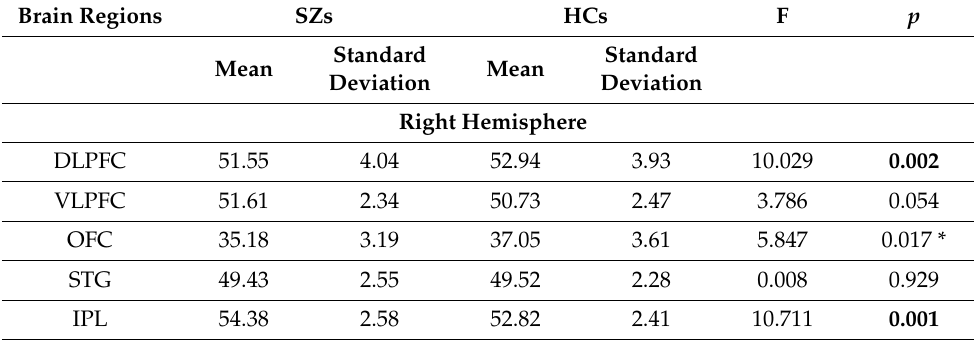
Table 2. Group comparison on resting-state